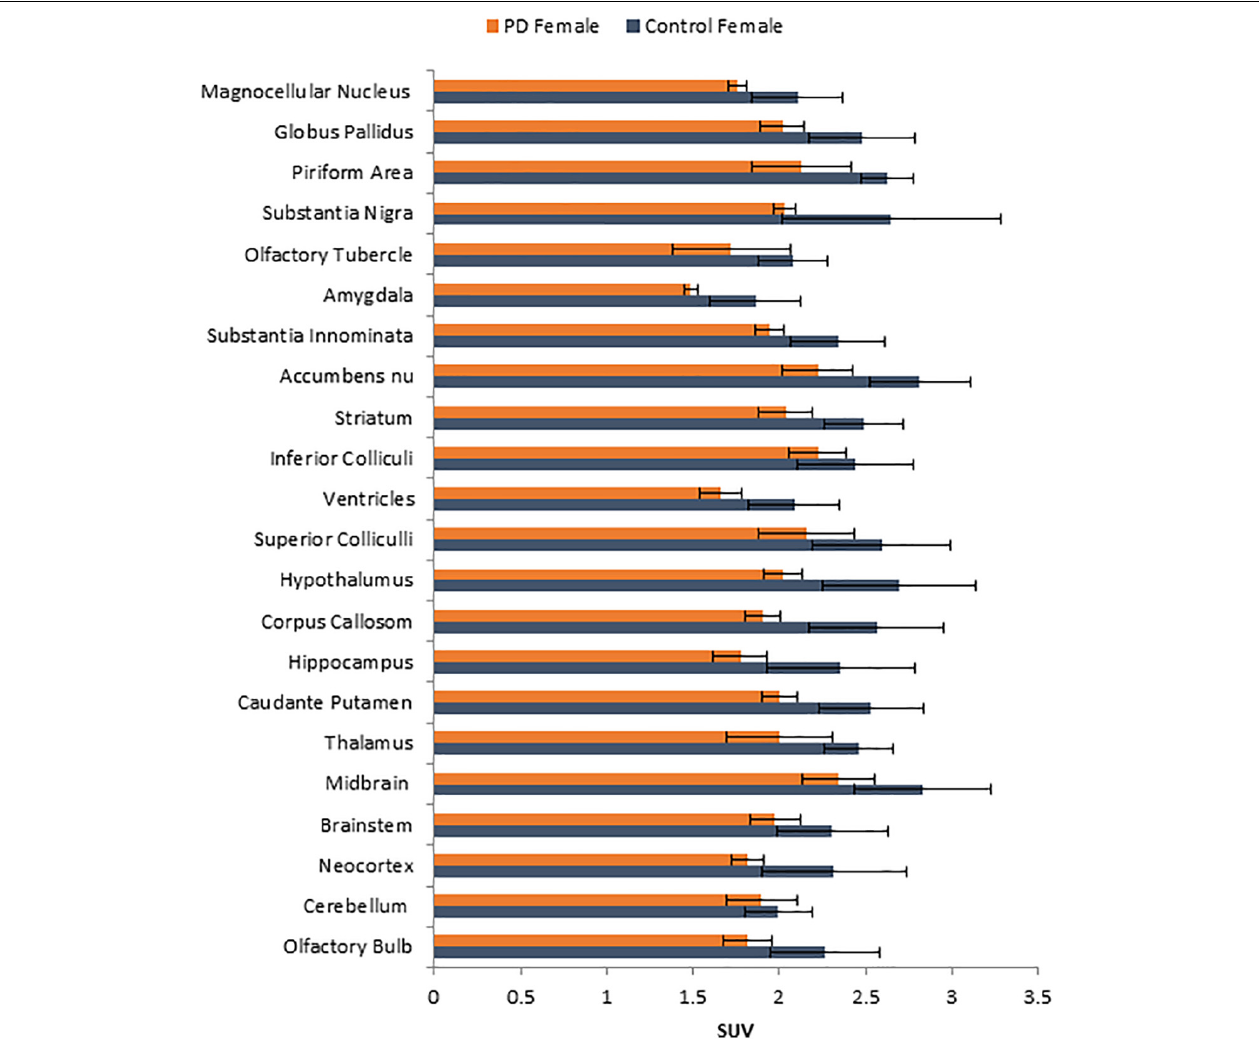
FIGURE 2 | Comparison of average [ 18 F]FDG standard uptake values (SUV) with standard deviation of female non-carrier mice with A53T PD female mice across different brain regions shown in Figure 1K .